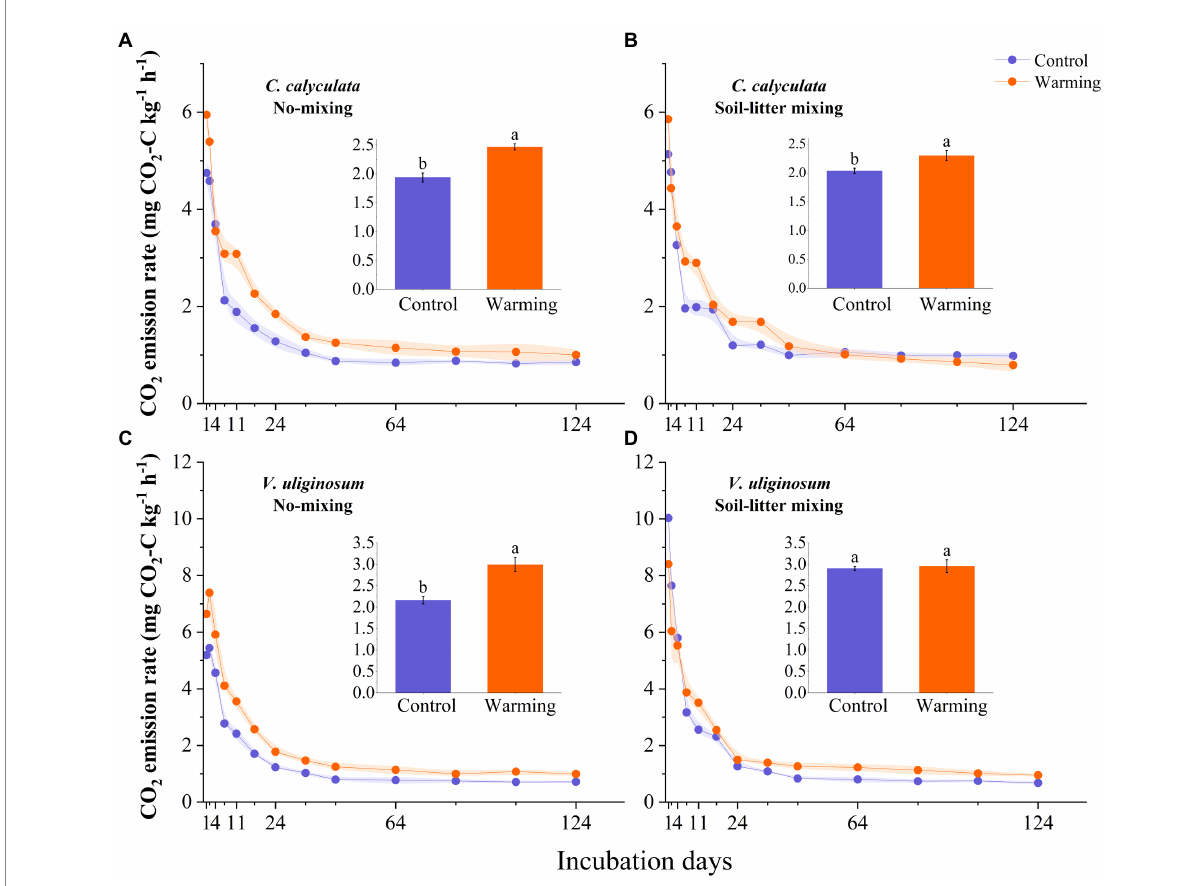
FIGURE 1 The dynamic CO 2 emissions rate for the C. calyculata ( A,B ) and V. uliginosum ( C,D ) litter decomposition under warming and treatments with different positions. On each solid line, the shading around the points represents the mean ± standard deviation ( n = 4 replicates). The panel inset shows the average CO 2 emission rate throughout the incubation period, under the different treatments (the different letters in the insets represent statistical differences ( p < 0.05) based on a Tukey’s multiple comparison test).